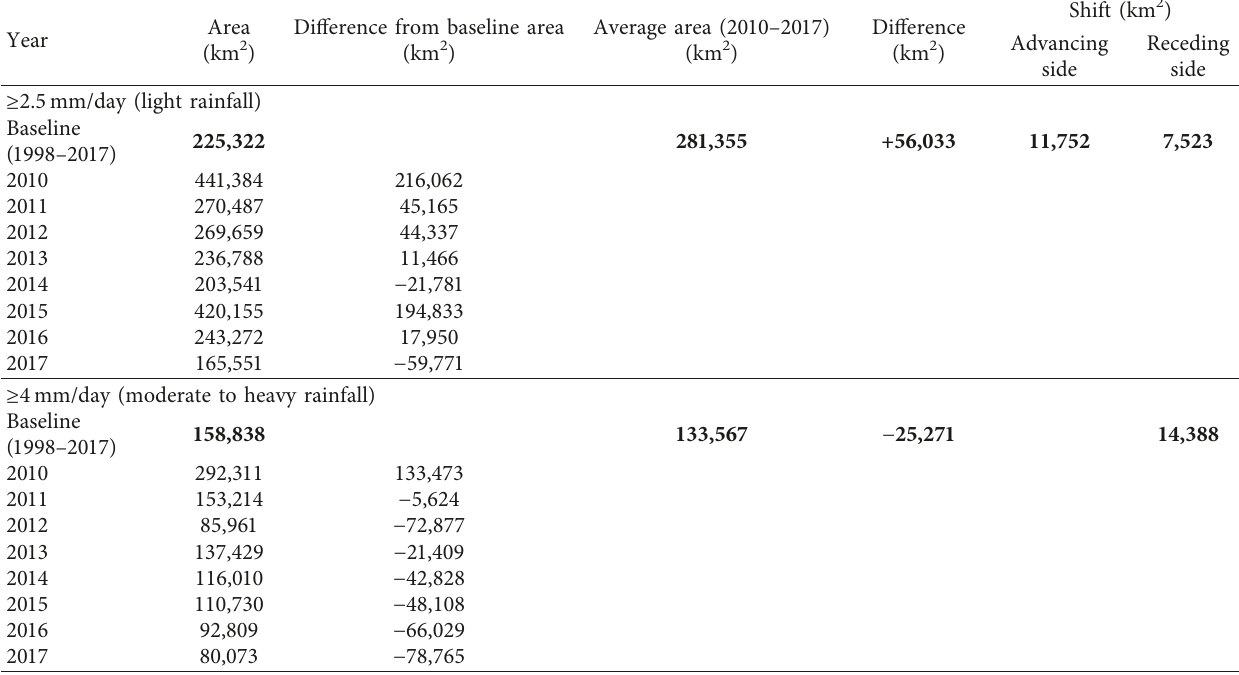
Table 4: Extent of spatial shift of monsoon over northern monsoon belt of Pakistan for different thresholds of rainy and moderate to heavy